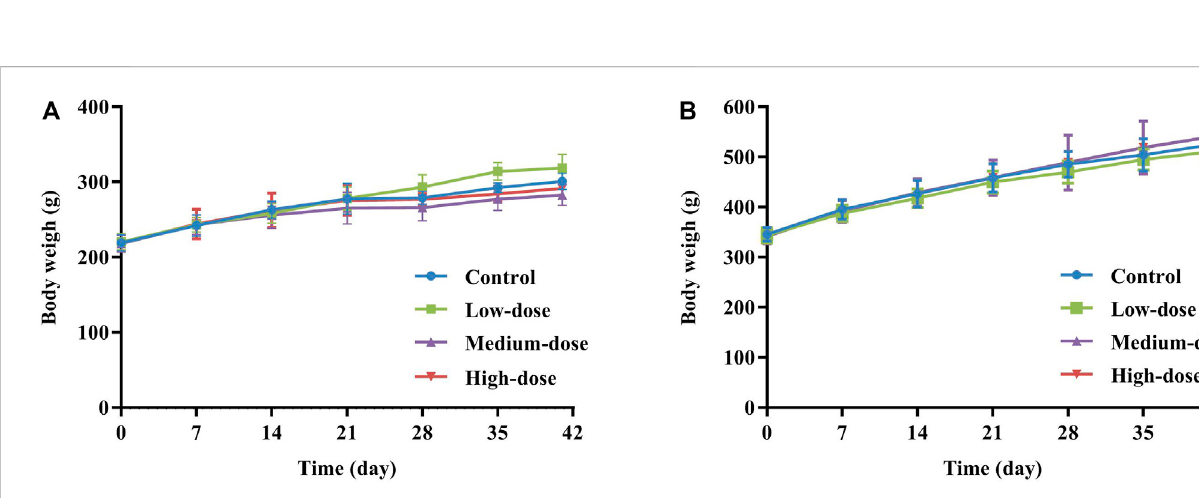
FIGURE 2 Mean body weights of female (A) and male (B) rats in subacute toxicity